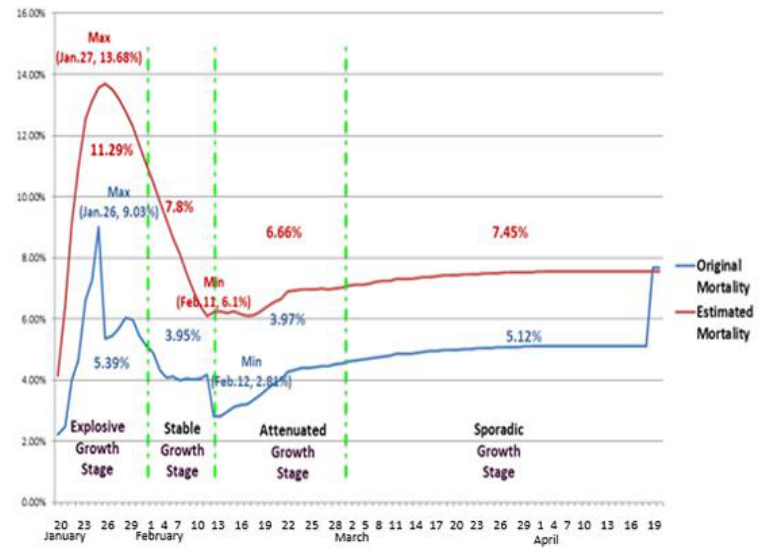
Figure 12. Original mortality rate and estimated mortality rate in Wuhan. The blue line represents the original mortality rate, and the red line represents the estimated mortality rate. Our results show that the average mortality rate is the highest in the explosive growth stage, 7.8% in the stable growth stage, and 6.66% in the attenuated growth stage. In the sporadic growth stage, the average mortality rate is 7.45%.